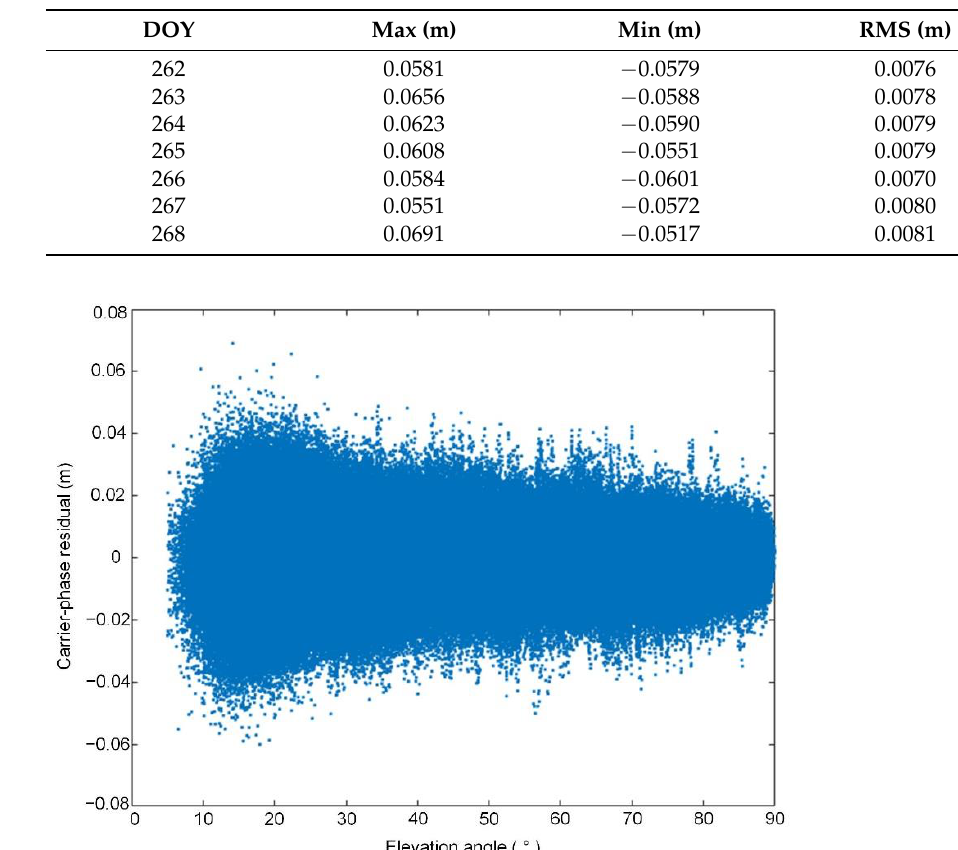
Figure 2. Carrier-phase residuals sequence.